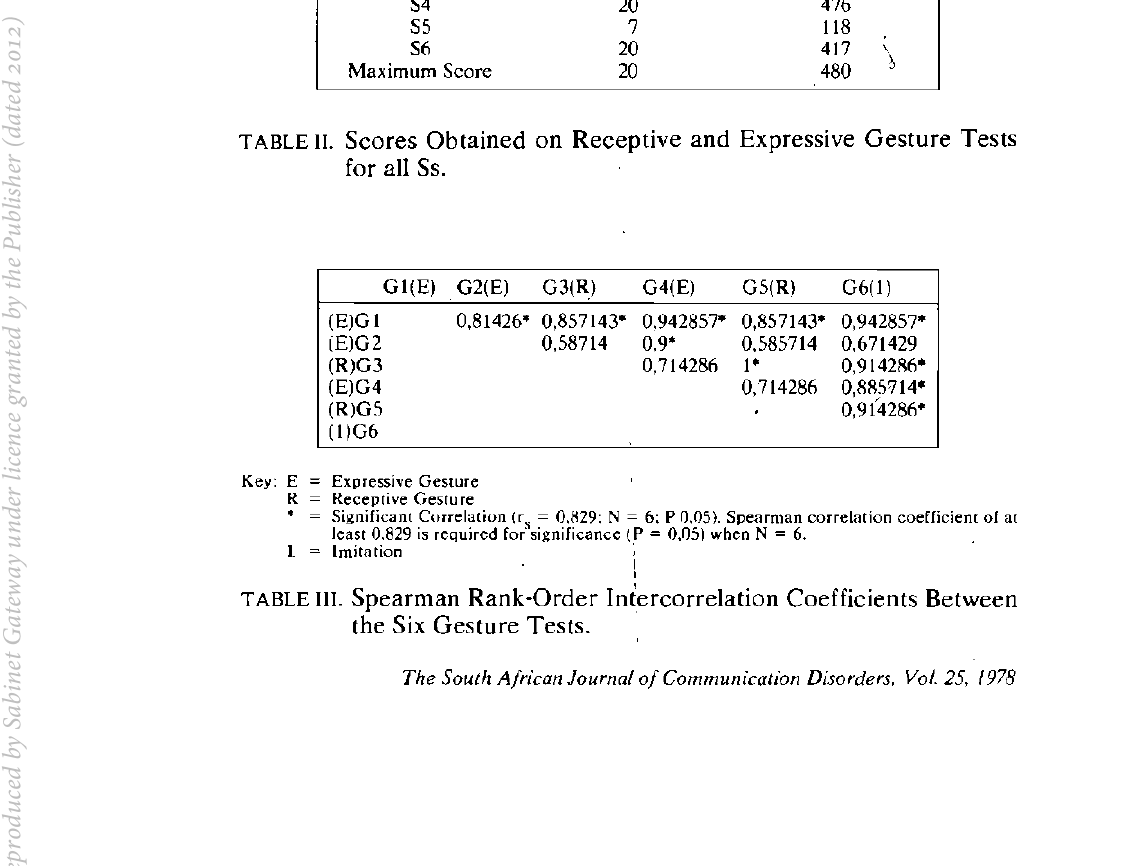
TABLE III. Spearman Rank-Order Intercorrelation Coefficients Between the Six Gesture